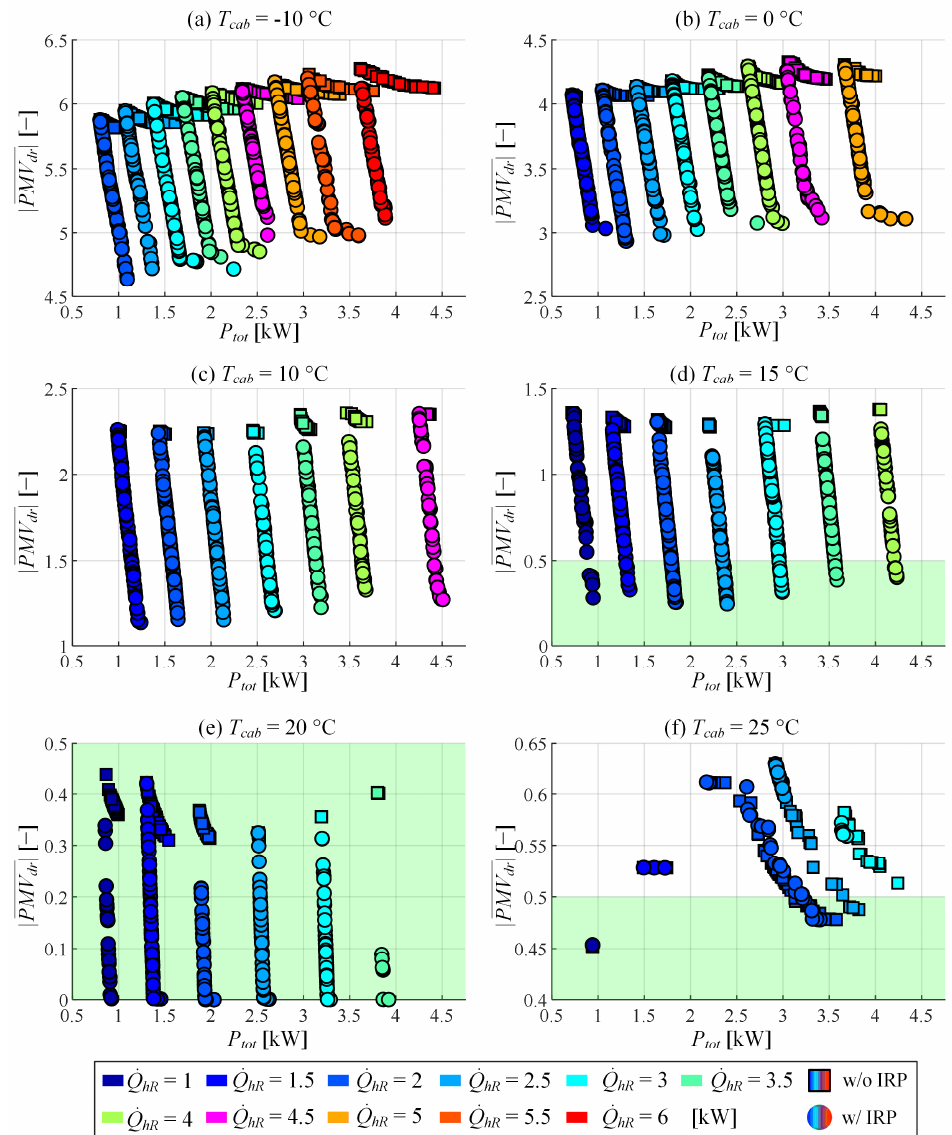
Figure 5. Comparison of multi-objective Pareto optimal results for cases with (circles) and without use of infrared heating panels (IRPs) (squares) at different cabin temperatures ( a – f ).